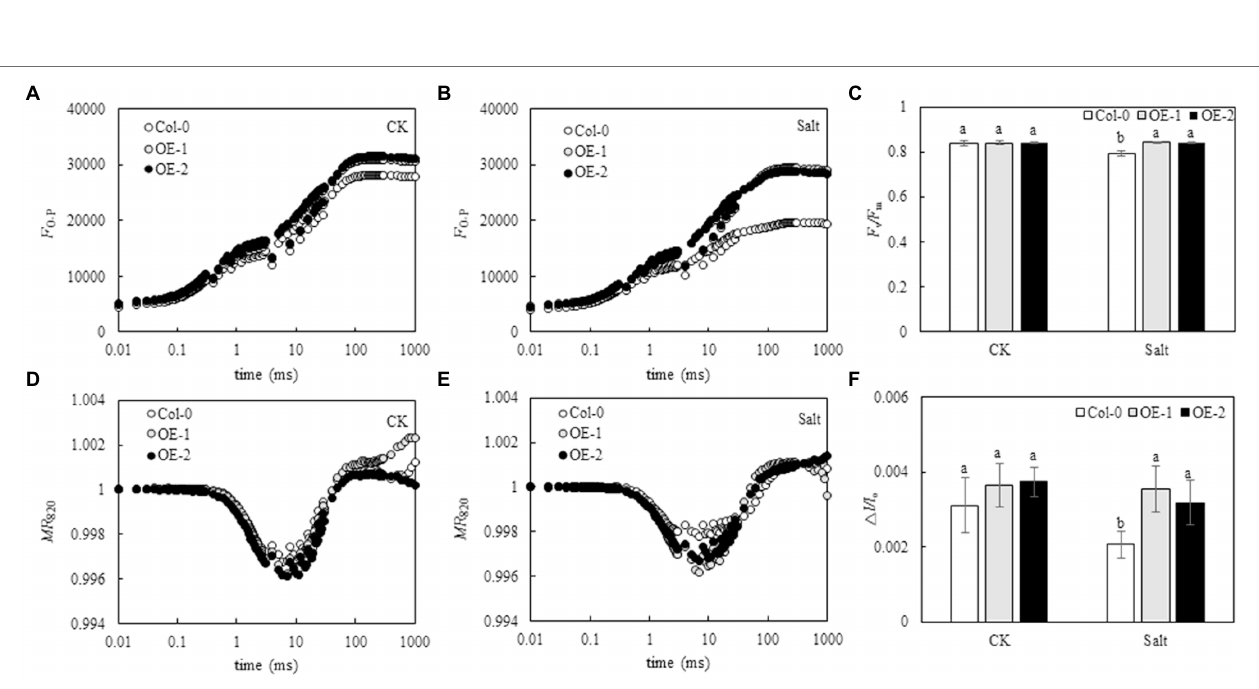
FIGURE 4 | Effects of MYB37 overexpression on OJIP curve (A, B) , MR 820 curve (D, E) , F v / F m (C) , and ∆ I / I o (F) in Arabidopsis leaves under NaCl stress. Data are expressed as means ± SE of three replicated experiments ( n = 3). Different small letters indicate significant differences ( p <